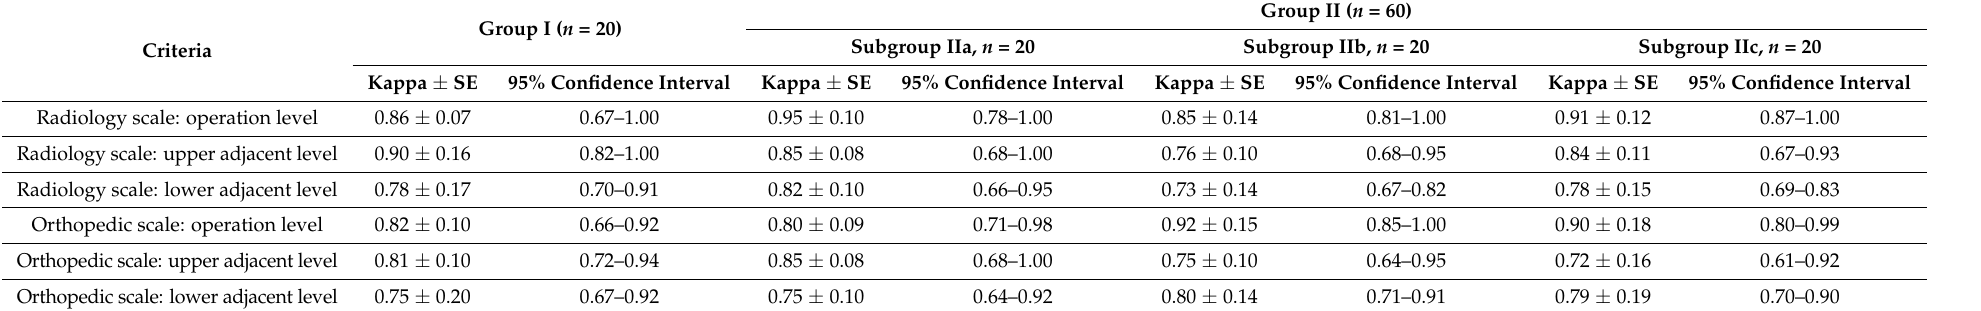
Table 4. Interobserver agreement by radiological and orthopedic scales for MRI artifact evaluation [13].